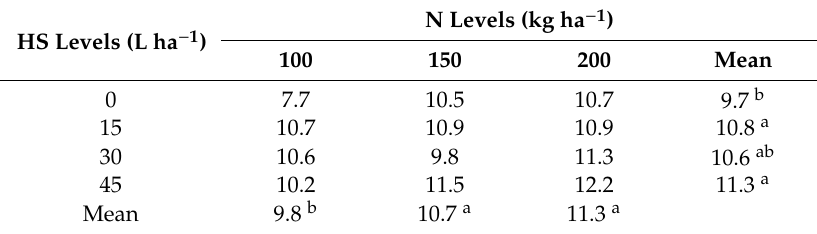
Table 3. E ff ects of the N and HS applications on DMY of sweet sorghum (data over two